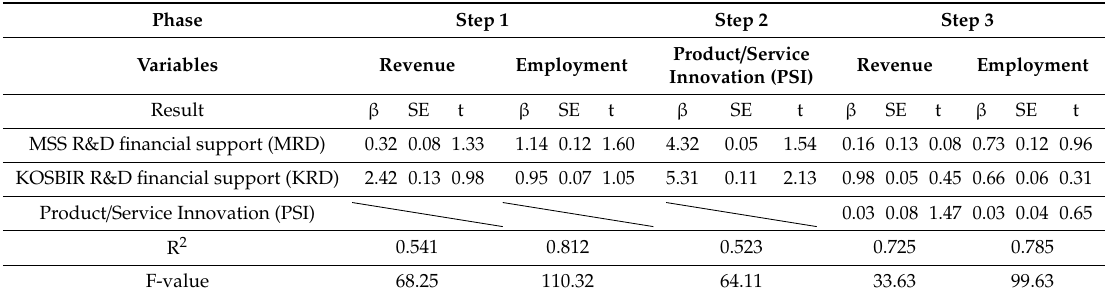
Table 3. Factors a ff ecting increase on business performance and mediating e ff ect of product and service innovation (PSI).